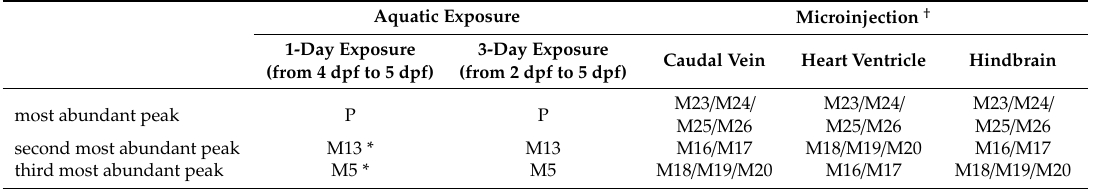
Table 3. Comparison of the major metabolites visualized in ZF larva by MALDI-FT-ICR. Aquatic